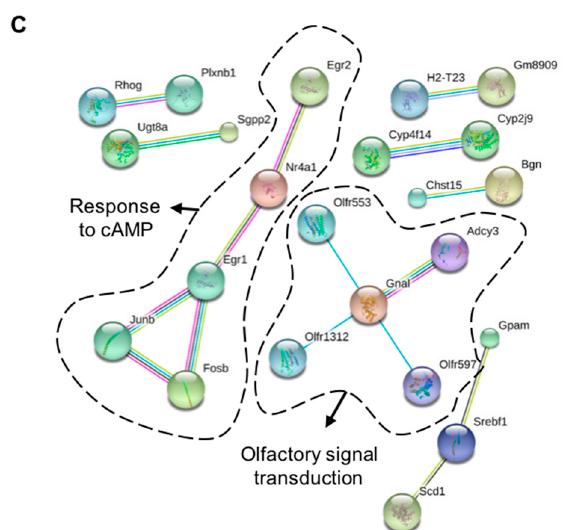
Figure 2. Multi-omic approach to decipher the OB site-specific molecular signature in aged Tg2576 mice. ( A ) Differential molecular profiling detected by the dual-omic approach in Tg2576 OBs. The olfactory protein expression levels of amyloid precursor protein (APP) at late Alzheimer’s disease (AD) stages in 18-month-old Tg2576 mice is shown. Equal loading control and quantitation values have been included in Table S5; ( B ) Heat map representing the degree of change for the differentially expressed proteins (Table S2) between 18-month-old wild-type (WT) and Tg2576 mice. Red and green, up- and down-regulated proteins, respectively; ( C ) Gene interactome networks for the differentially expressed genes detected in aged Tg2576 mice. Network analysis was performed submitting the corresponding gene IDs to the STRING software (v. 10.5) (Available online: https://string-db.org/). Only interactions tagged as “high confidence” (>0.7) in STRING database were considered. Dashed circles highlight the potential alteration in the response to cyclic adenosine monophosphate (cAMP) and in the olfactory transduction signaling.